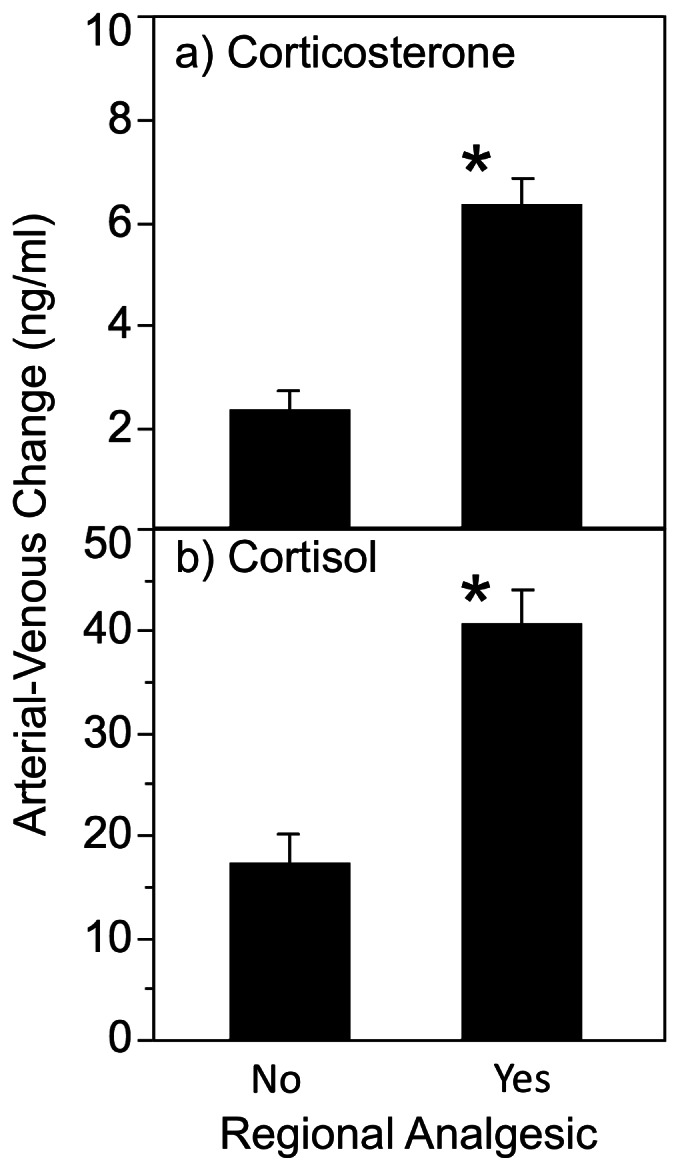
Maternal regional analgesia increases absolute fetal glucocorticoid synthesis.For vaginal deliveries only (Vag), absolute increase [A-V] ng/ml in concentration after passage of the fetus for corticosterone (panel a) and cortisol (panel b) in the absence (N = 46) or presence (N = 117) of regional maternal analgesia (i.e. epidural). The asterisk indicates a significant increase in corticosteroid synthesis in the presence of maternal analgesia.